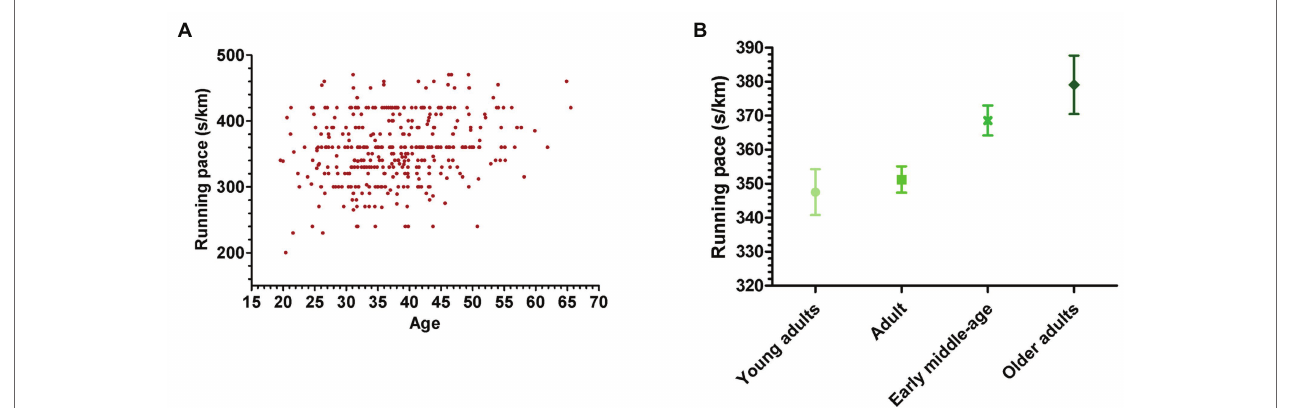
FIGURE 2 | Running pace (s/km) for each subject (A) and box-plot to running pace by age groups (B)